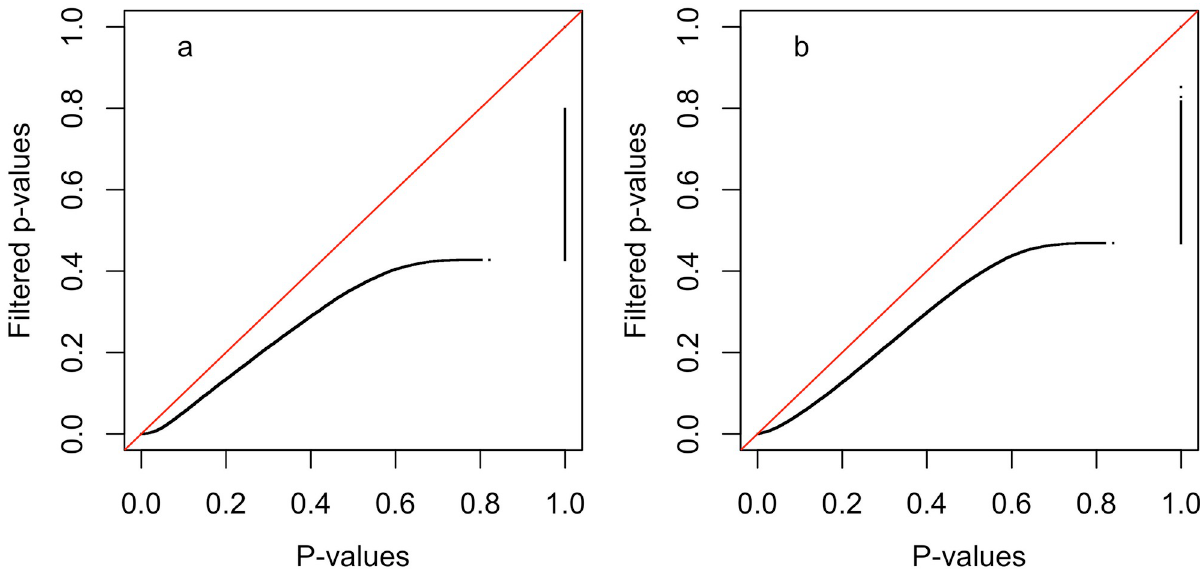
Fig 6. Quantile-quantile plots illustrating impact of tissue-specific gene filtering on the distribution of p-values from Kaplan-Meir (KM) tests of the association of gene expression with cancer survival as computed using the approach of Ulhen et al. [18]. Each plot contrasts the distribution of p-values (the black line) for all genes for each of the 21 cancer types or for genes filtered according to tissue-specificity. The red line has a slope of 1.0 and captures the distribution that would be expected if filtered and un-filtered p-values had the same distribution. In both panels, the x-axis reflects the p-value distribution when all genes are included and the y-axis reflects the p-value distribution when genes are filtered according to normal tissue- specificity ( n � ). Panel a) contains the results when only favorably prognostic genes are considered (i.e., genes where increased expression is associated i ; j with better survival; p-values for unfavorable genes were set to 1.0) and gene filtering removed genes where n � < log ð 0 : 8 Þ (i.e., removed genes i ; j expressed at a lower level in the associated normal tissue than in the average tissue). Panel b) contains the results when only unfavorably prognostic genes are considered (i.e., genes where increased expression is associated with worse survival; p-values for favorable genes were set to 1.0) and gene > log ð 1 : 2 Þ (i.e., removed genes expressed at a higher level in the associated normal tissue than in the average tissue). filtering removed genes where n � i ; j As illustrated in the Q-Q plots, gene filtering in both cases improved survival analysis statistical